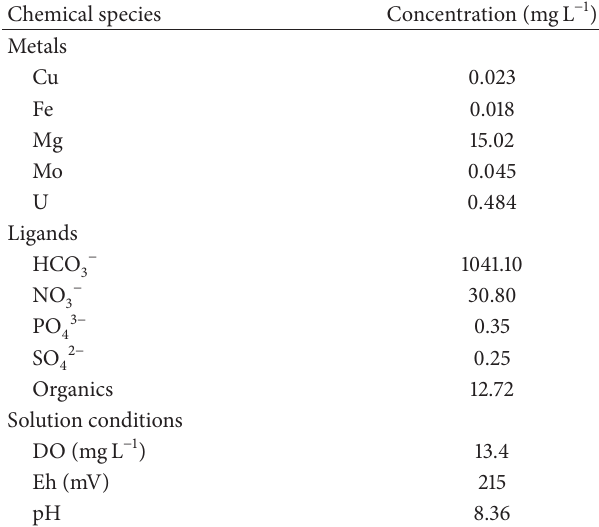
Table 2: Concentrations of notable chemical species present in the mine water, analysed by ICP-MS (U), ICP-AES (Fe, Mg, Cu, and − , NO 3 − , and PO 3− ), gravimetry Mo), volumetric titration (HCO 3 4 (SO 42 − ), and solvent extraction (organics) along with the recorded Eh, pH, and DO prior to nanoparticle